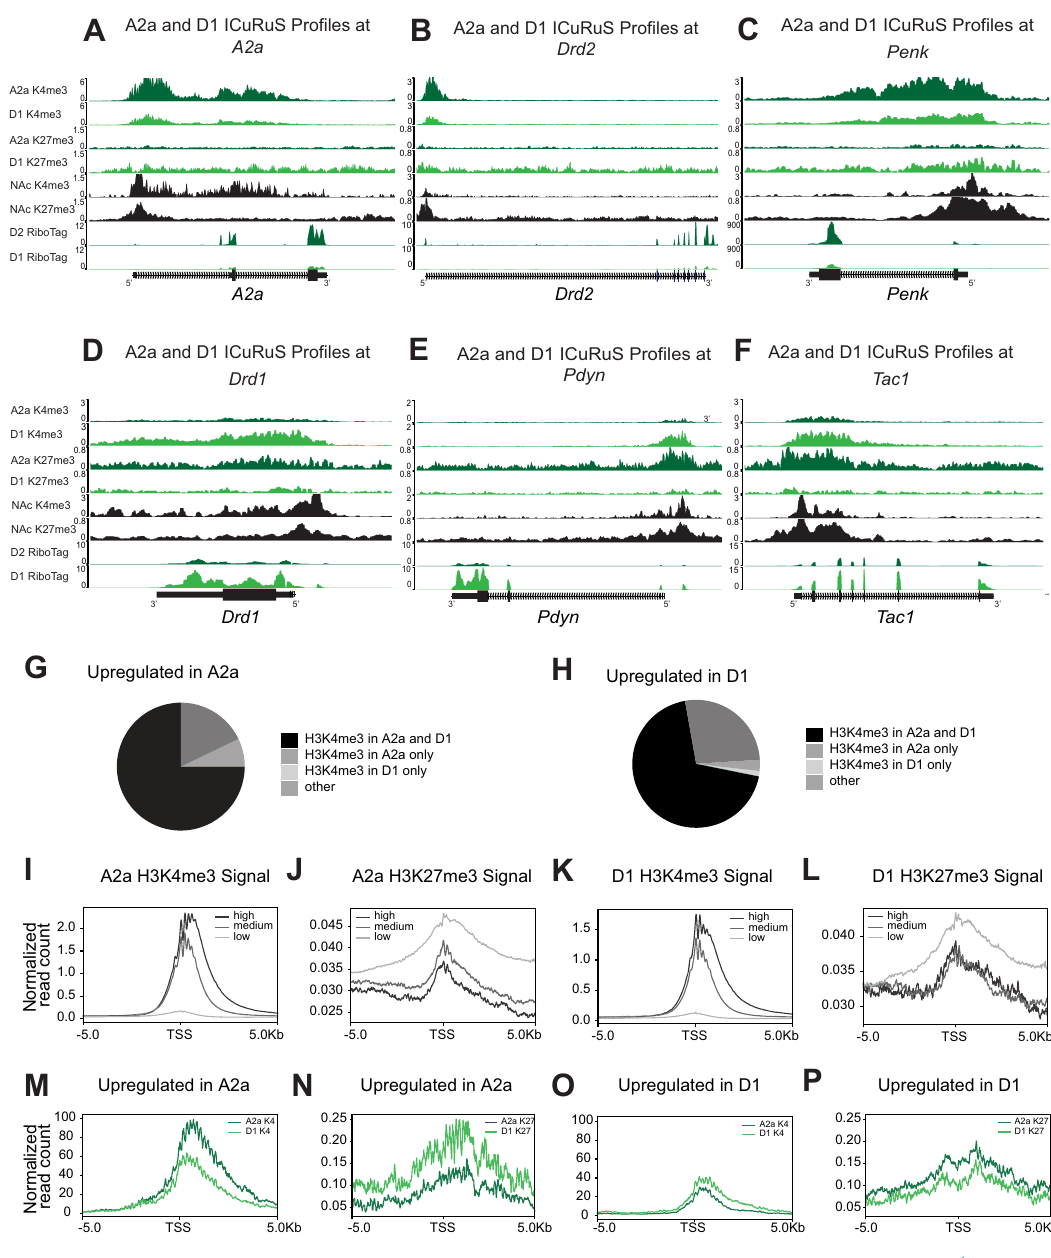
Fig. 3 | Comparison of peak loci across cell-types. A-C ) A2a and D1 speci fi c H3K4me3 and H3K27me3 modi fi cations around known A2a-speci fi c cell-type markers ( A ) A2a, (B) Drd2, and ( C ) Penk . D-F) A2a and D1 speci fi c H3K4me3 and H3K27me3 modi fi cations around known D1-speci fi c cell-typemarkers( D ) Drd1 , ( E ) Pdyn,and( F ) Tac1 .( G )PeaksatA2aand( H )D1upregulatedgenes;celltype-speci fi c genes de fi ned by |log2foldchange|> 1 and adj P <0.05.( I )A2a H3K4me3signal,( J ) A2a H3K27me3 signal, ( K ) D1 H3K4me3 signal, ( L ) and D1 H3K27me3 signal cen- tered on transcription start site (TSS). For each cell-type and hPTM, genes are categorized into 3 groups: high (FPKM>=10), medium (1<= FPKM<10), and low